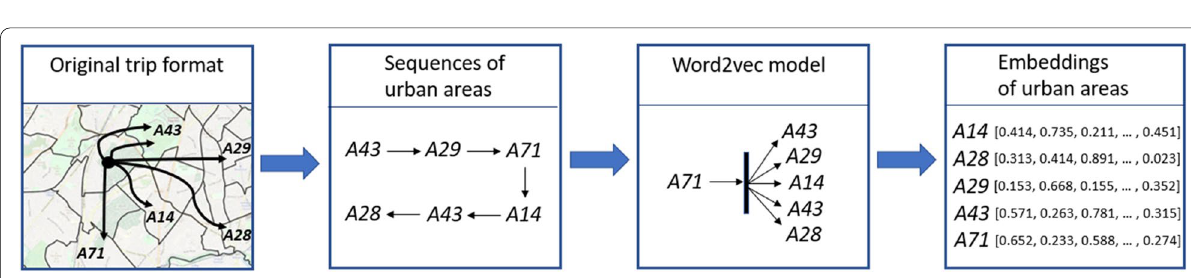
Fig. 2 Mobility embedding generation